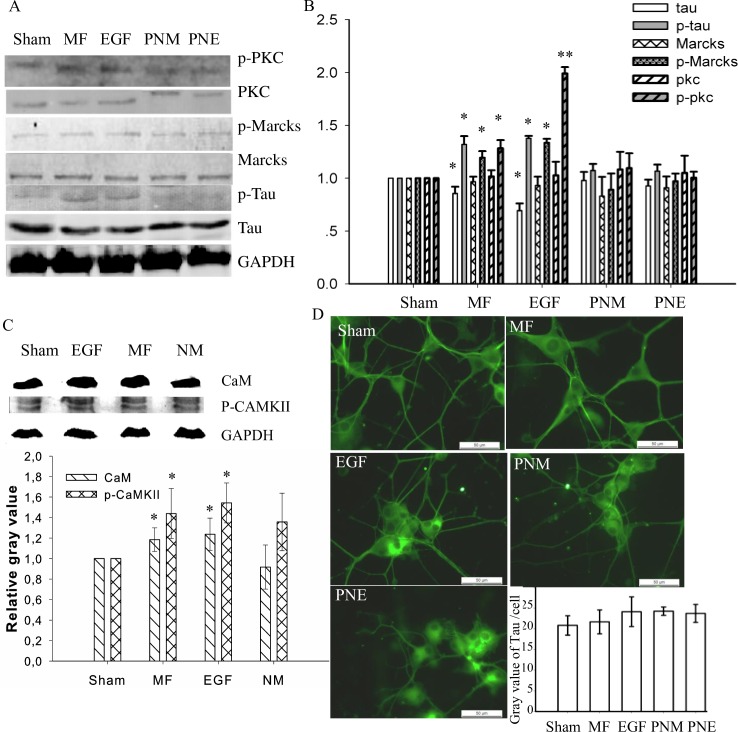
MF activated signaling proteins relative to both EGFR and calcium.A and B: Western blot of the indicated proteins (A) and the relative gray value / content of the proteins to the Sham groups after normalized with the GAPDH content (B); C: CaM and p-CAMKII by immunoblot (upper) and the quantification relative to the Sham after normalized to GAPDH (lower); D: Protein tau in PC12 cells by immunofluorescence. The groups in A, B, and D were treated as described in Fig 1 and in Materials and Methods; while the groups in C were treated as described in Fig 7B. * and ** in B and C: p-value < 0.05 and < 0.01 when compared with Sham by Student’s t-test, respectively. In D, the horizontal bars represent 50 μm; the average gray value per cell computed from at least 80 cells in each condition was shown in the histogram. The repeat time and analyzed cell number were described in detail in S1 Table.